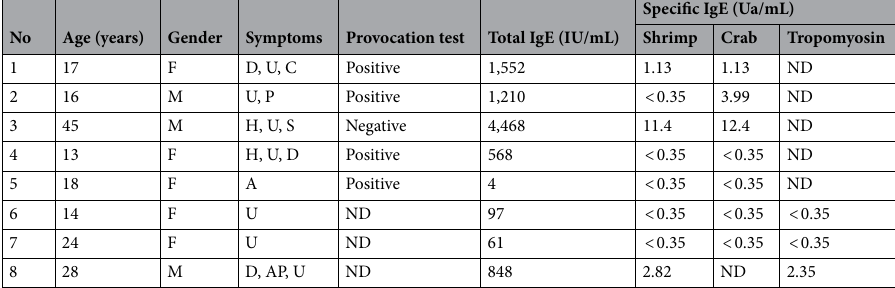
No Age (years) Gender Symptoms Provocation test Total IgE